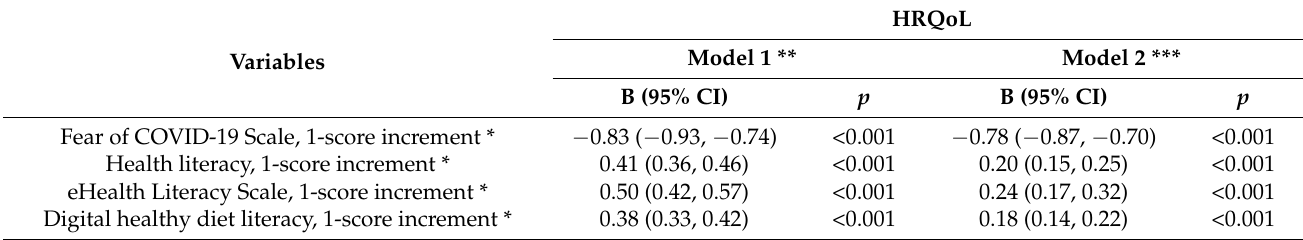
Table 3. Associations of fear of COVID-19, health literacy, eHealth literacy, and digital healthy diet literacy with health- related quality of life using multiple linear regression models (N =